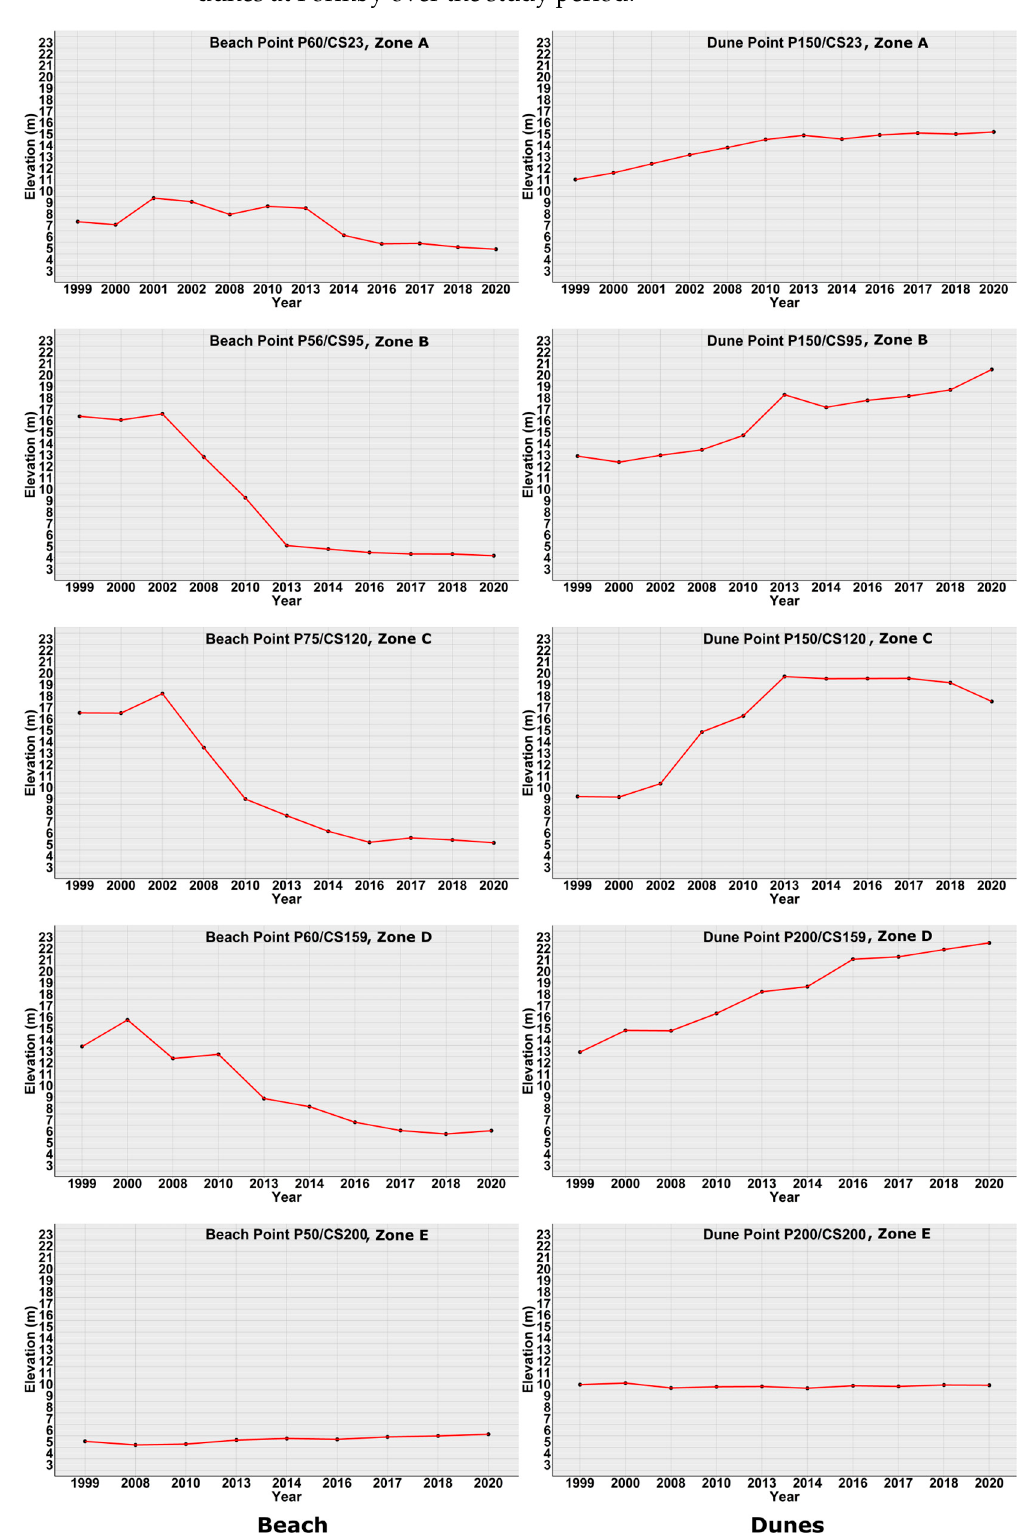
Figure 10. Selected elevation points profiles from zones A, B, C, D, and E on the beach and the dunes. This figure shows the elevation time series changes for individual points over the study period.